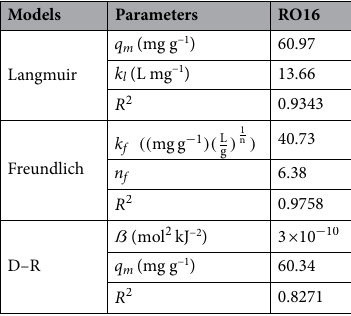
Table 2. Isotherm constants of RO16 adsorption by lignocellulosic sawdust-Fe/Zn composite.